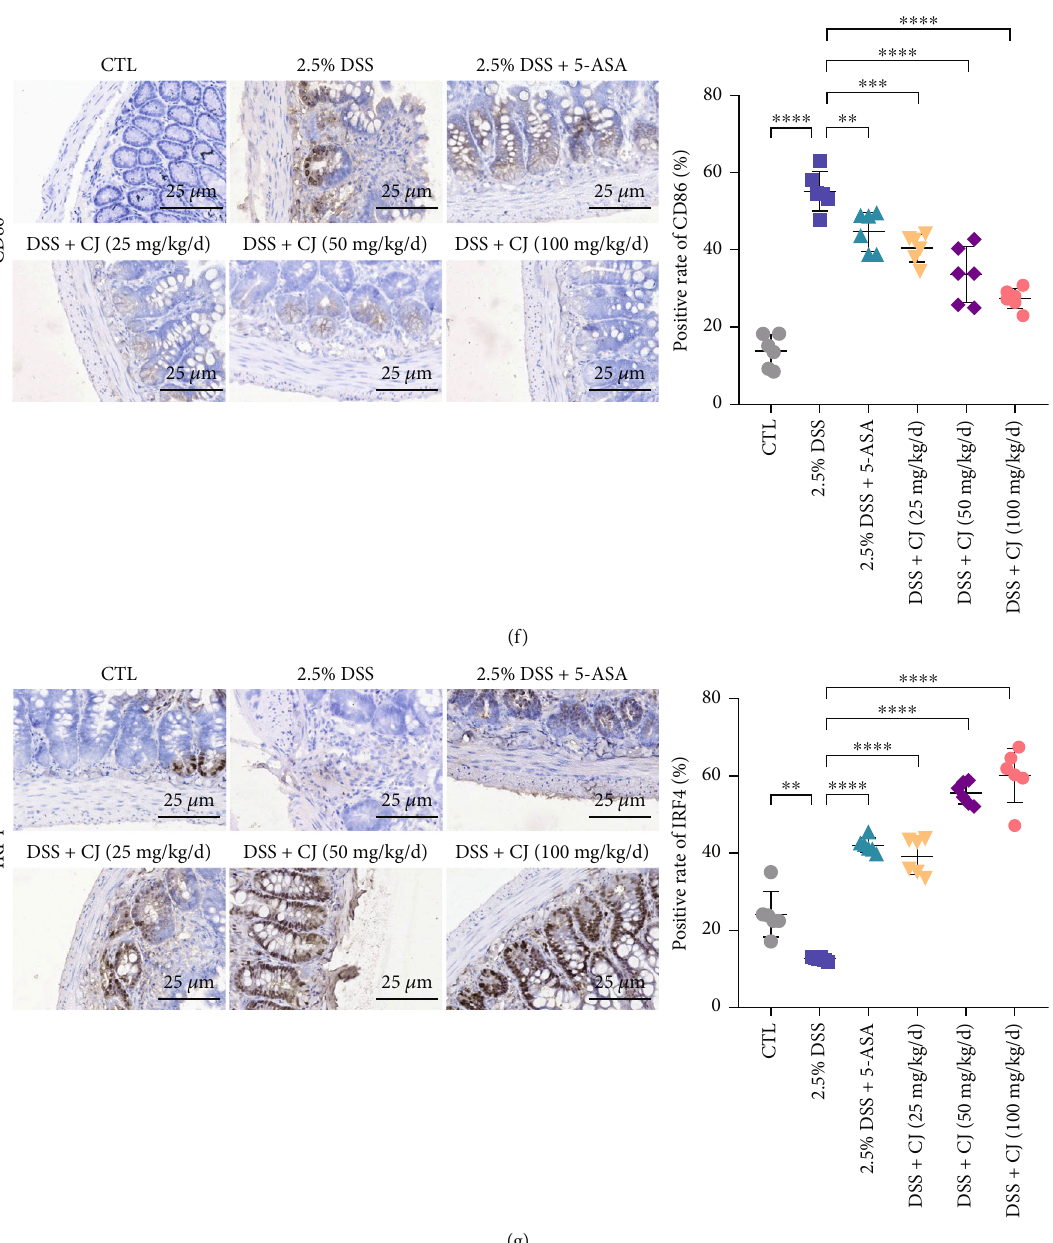
Figure 3: E ff ect of CJ on macrophage polarization in DSS-induced UC mice. (a) Loss of body weight after di ff erent administrations. (b) Colon length of mice after di ff erent administrations. (c) DAI score of mice after di ff erent administrations. (d) H&E staining for colon tissue damage after di ff erent administrations. Arrows show in fl ammatory in fi ltration, mucosal erosion, and crypt damage. (e) F4/ 80 + CD11b + cell and F4/80 + CD206 + cell signals in the spleen shown by fl ow cytometer. (f) The expression of CD86 protein in the colon tissues of mice detected by immunohistochemistry. (g) The expression of IRF4 protein in the colon tissues of mice detected by immunohistochemistry. n = 6 . ∗ p < 0 : 05 ; ∗∗ p < 0 : 01 ; ∗∗∗ p < 0 : 001 ; ∗∗∗∗ p < 0 : 0001